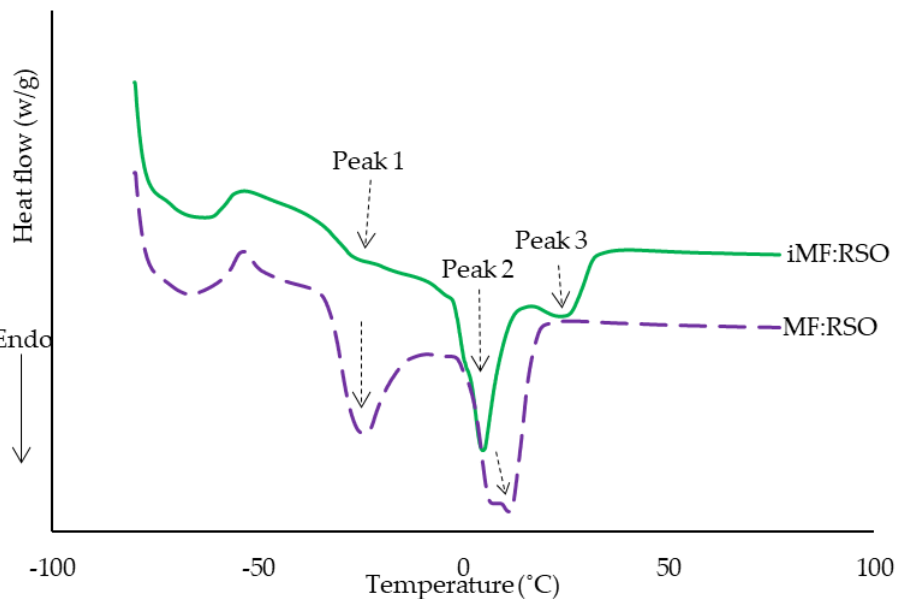
Figure 2 . Melting curves of the initial and interesterified mixtures of milkfat with rapeseed oil. MF:RSO—noninteresterified mixture of milkfat and rapeseed oil and iMF:RSO—interesterified mixture of milkfat and rapeseed oil.